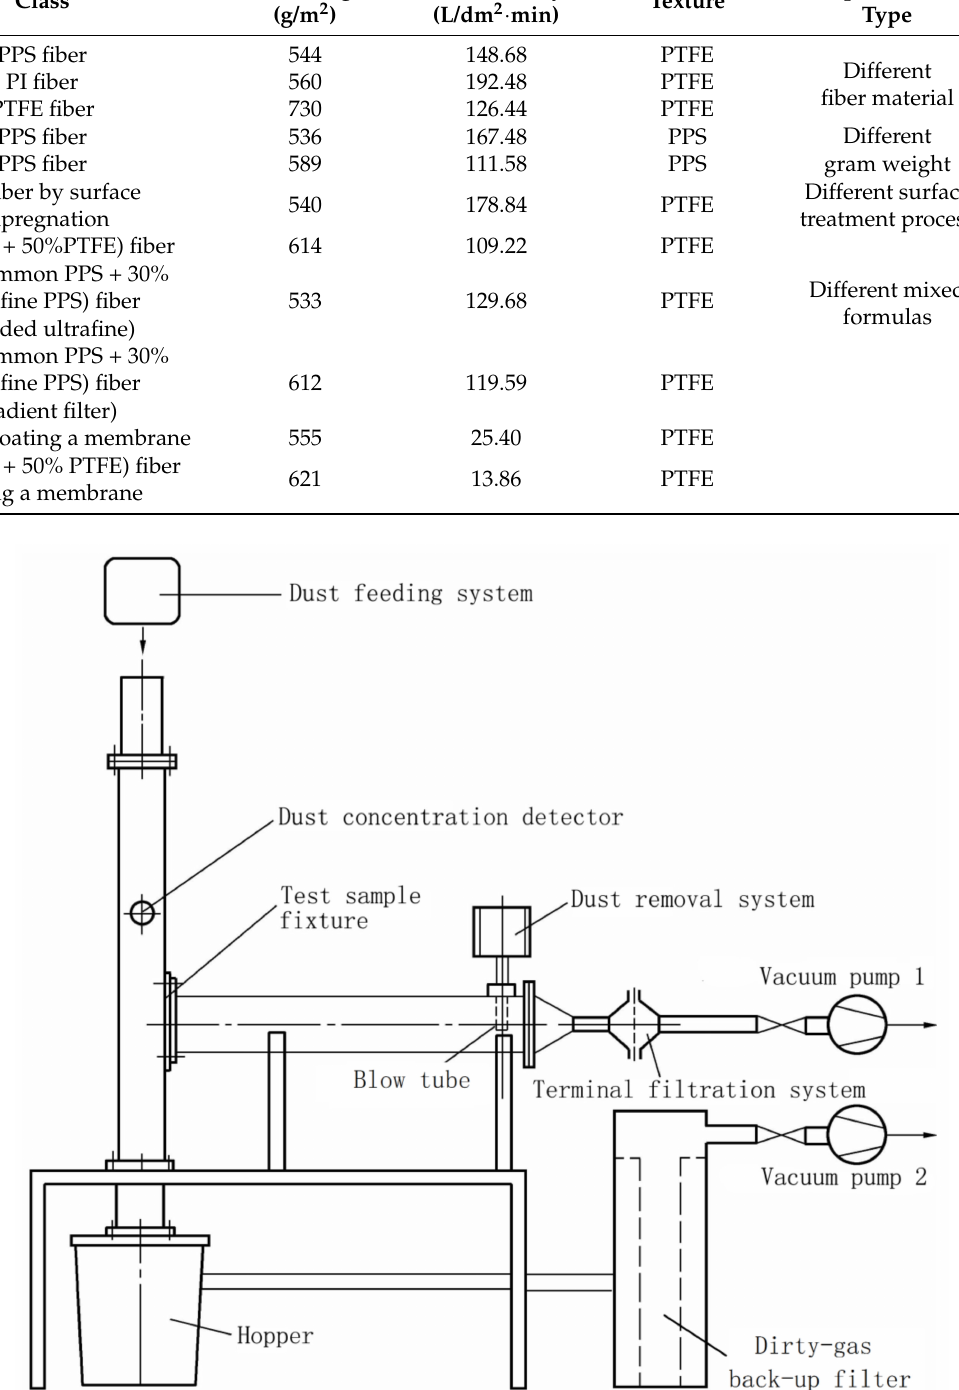
Figure 1. Filter material filtration performance test